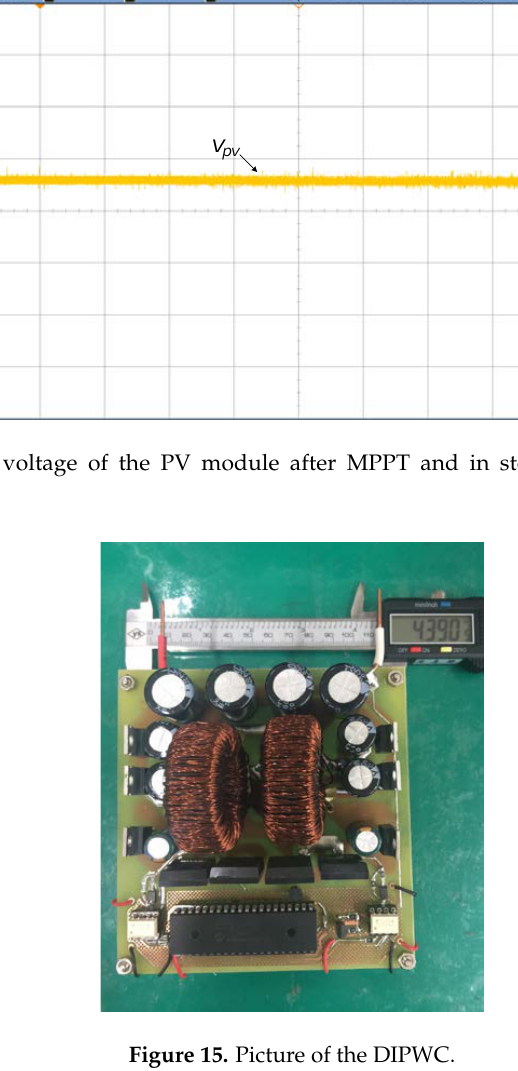
Figure 13. The practical MPPT result of the DIPWC at full load.